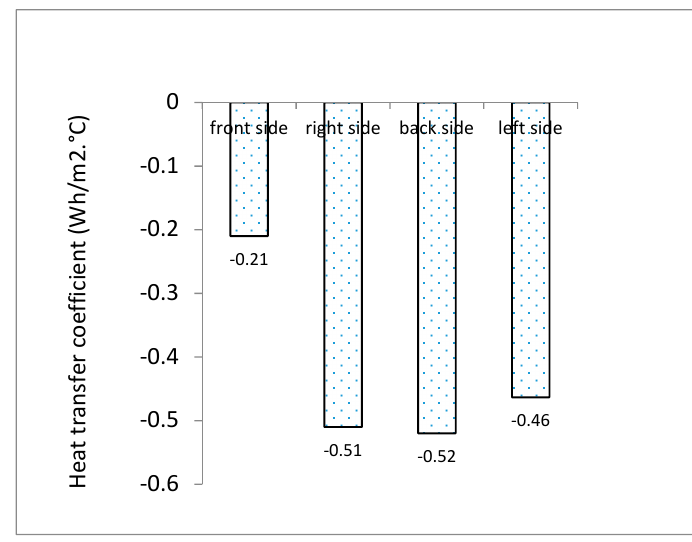
Figure 11. Interzonal heat loss at the four sides of the compound house.